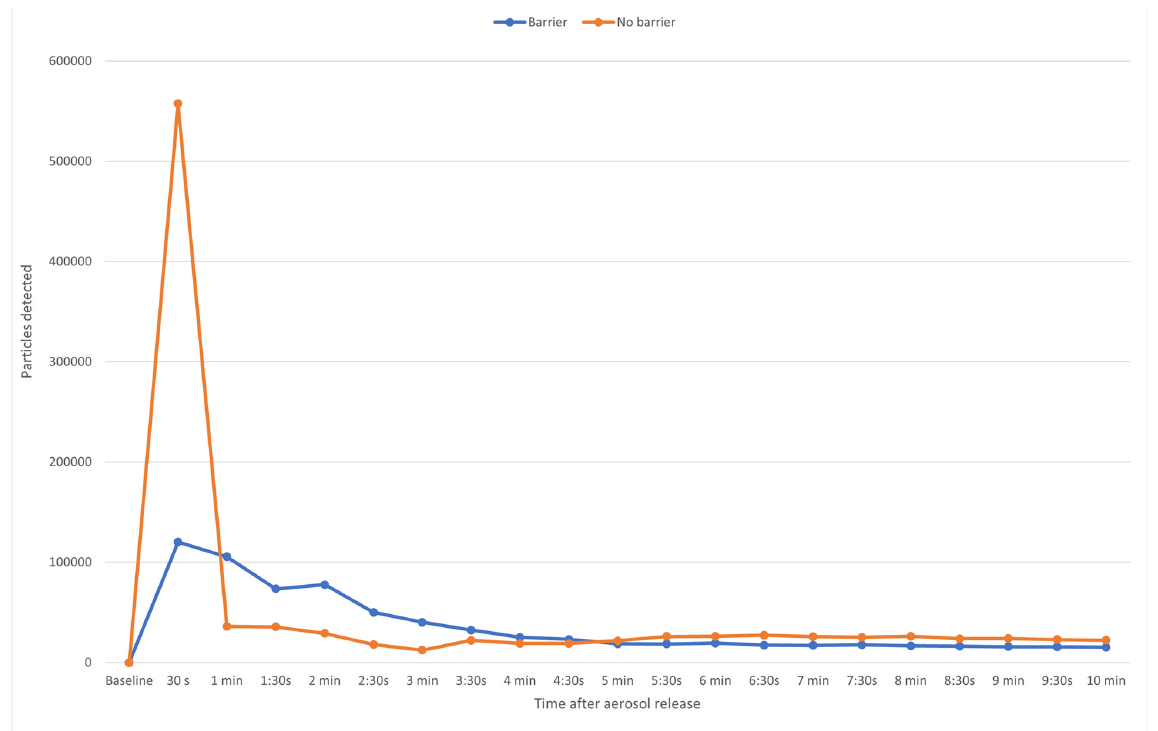
Figure 5. Detection of 5% sodium chloride aerosol particles behind a plexiglass barrier over 30 minutes after release with versus without a plexiglass barrier in place in a non-ventilated room. The aerosol particles were released at 91 cm from the barrier. Average results for 3 experiments are shown. Error bars represent standard